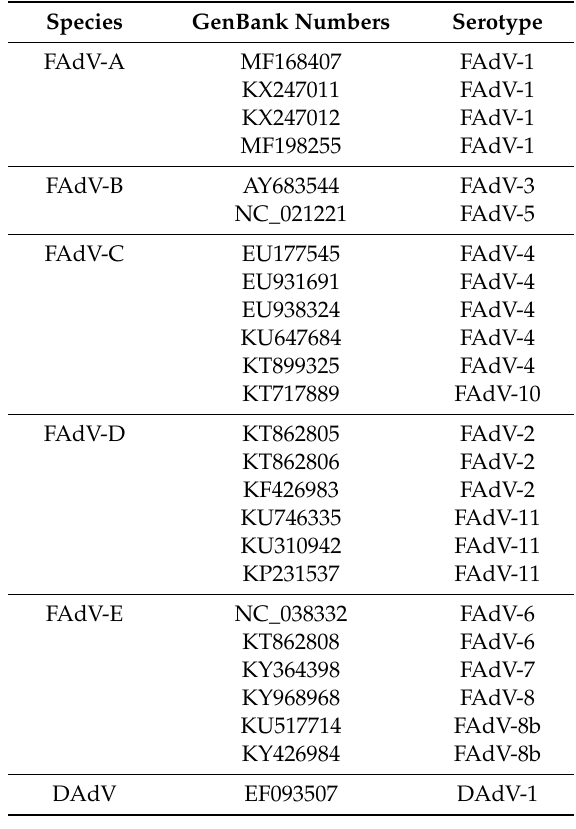
Table 1. The sequences information of FAdV reference strains used in this